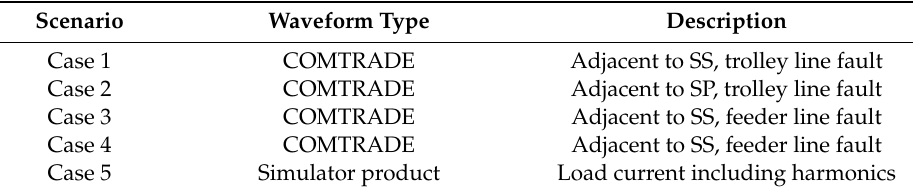
Table 4. Simulation scenario. SP: sectioning post, SS: substation.